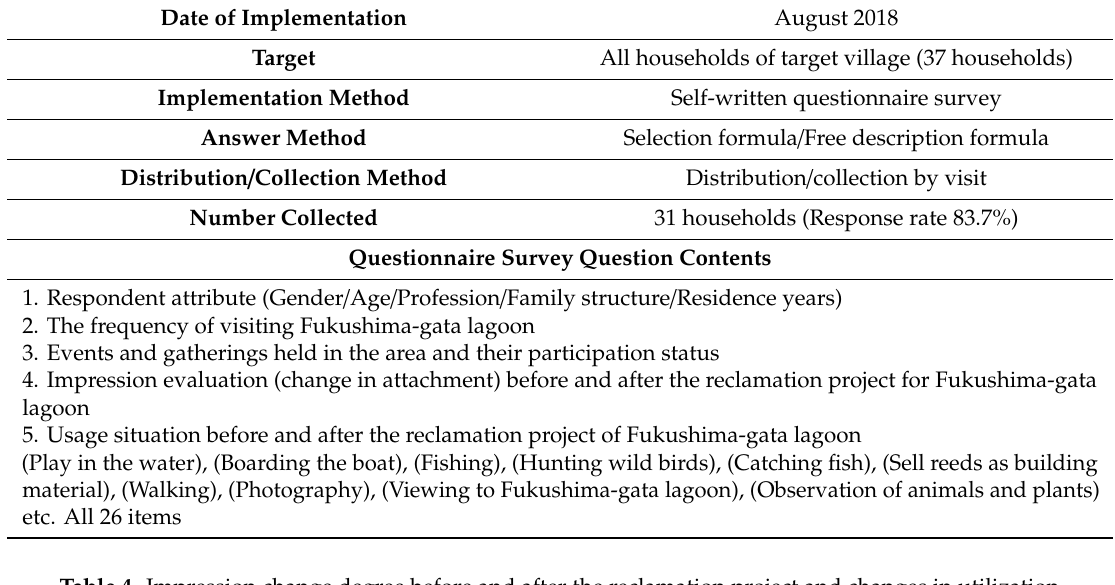
Table 4. Impression change degree before and after the reclamation project and changes in utilization before and after the reclamation project (n =